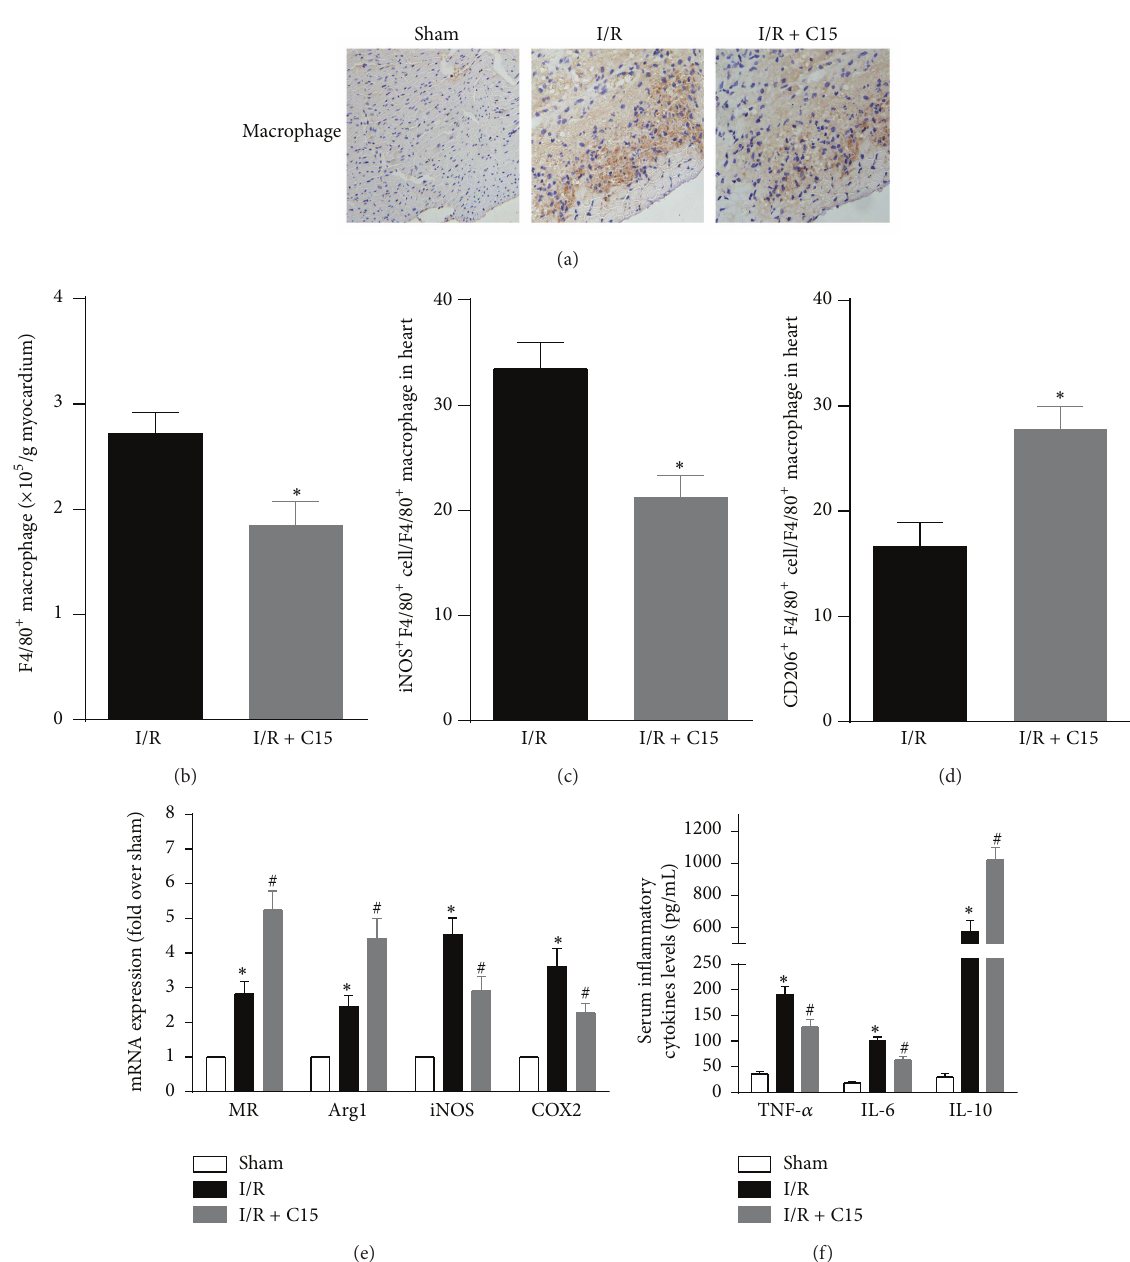
Figure 3: C15 generated alternatively activated macrophages in the ischemic myocardium. (a) Representative photographs of macrophage infiltration in the ischemic myocardium after 48 h of reperfusion. (b) The number of F4/80 + macrophages infiltrated into the ischemic myocardium was analyzed by flow cytometry ( 𝑛 = 6 ). (c) The number of classically activated M1 (iNOS + F4/80 + ) macrophages infiltrated into the ischemic myocardium was analyzed with flow cytometry ( 𝑛 = 6 ). (d) The number of alternatively activated M2 (CD206 + F4/80 + ) macrophages that were infiltrated into the ischemic myocardium was analyzed with flow cytometry ( 𝑛 = 6 ). (e) M1 and M2 markers were analyzed with real-time PCR ( 𝑛 = 6 ). (f) The serum levels of proinflammatory cytokines (tumor necrosis factor- 𝛼 (TNF- 𝛼 ) and interleukin-6 (IL-6)) and anti-inflammatory cytokines (IL-10) were measured after 48 h of reperfusion ( 𝑛 = 6 ). ∗ < 0.05 versus the I/R or sham groups; # < 0.05 versus the I/R